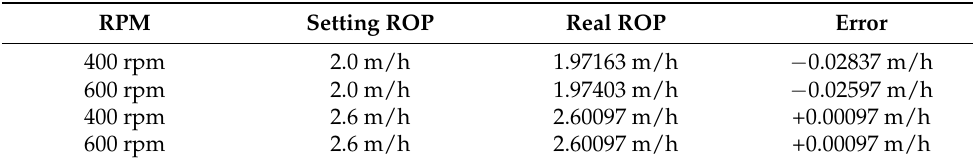
Figure 11. Test results for constant-speed drilling mode. Table 2. Test results in constant-speed drilling mode.